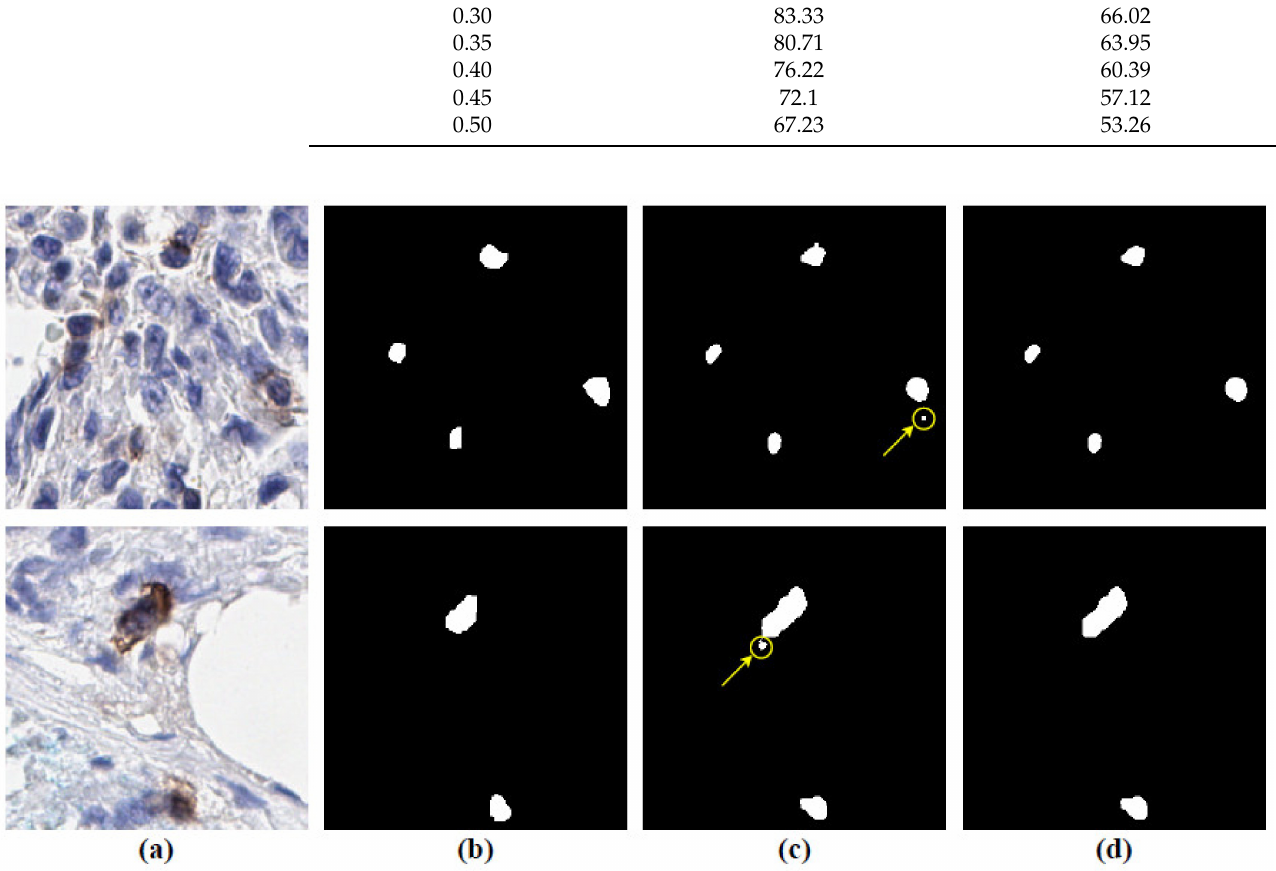
Figure 10. Visualization of the effect of post-processing method using two segmentation examples. ( a ) Original test images (randomly selected from the unseen test set), ( b ) annotated ground-truth by pathologist (binary regions corresponding to the original images), ( c ) predicted images by the model before applying the post processing method; yellow arrows are indicating the false positives are detection and ( d ) predicted images after applying the post-processing method; the detected false positives are